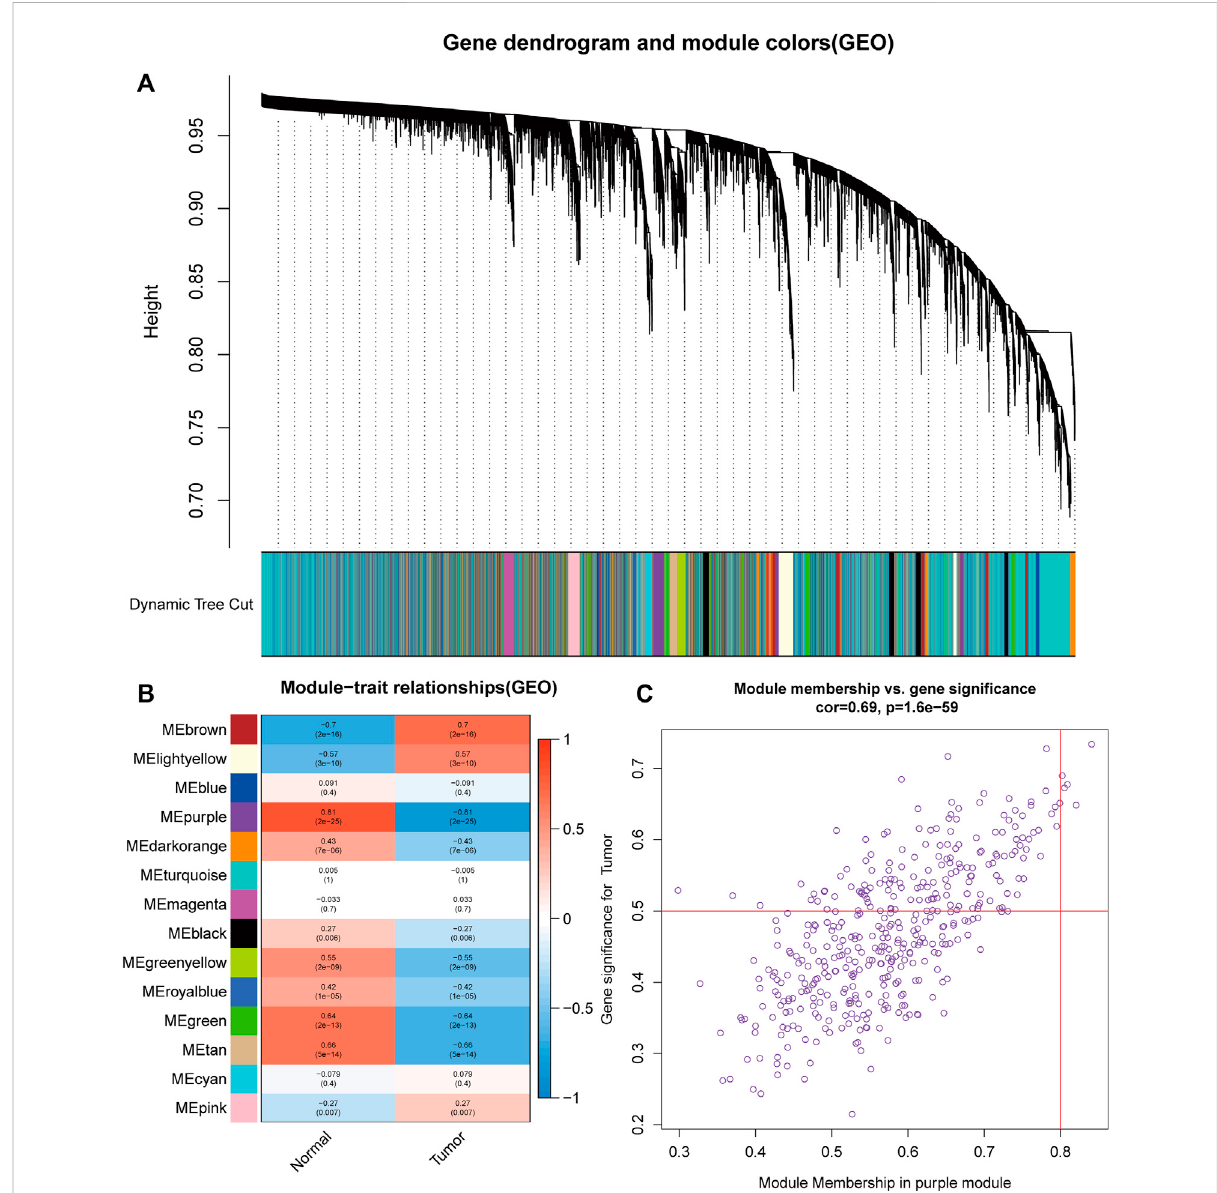
FIGURE 2 Identi fi cation of module data pertaining to the pathological tissue type in GSE17025. (A) Identi fi cation of modules by dynamic tree cutting in GSE17025. (B) Heatmap of module – trait relationshipsin GSE17025. (C) Scatter plots of module membershipvs. gene signi fi cance in theMEpurple in